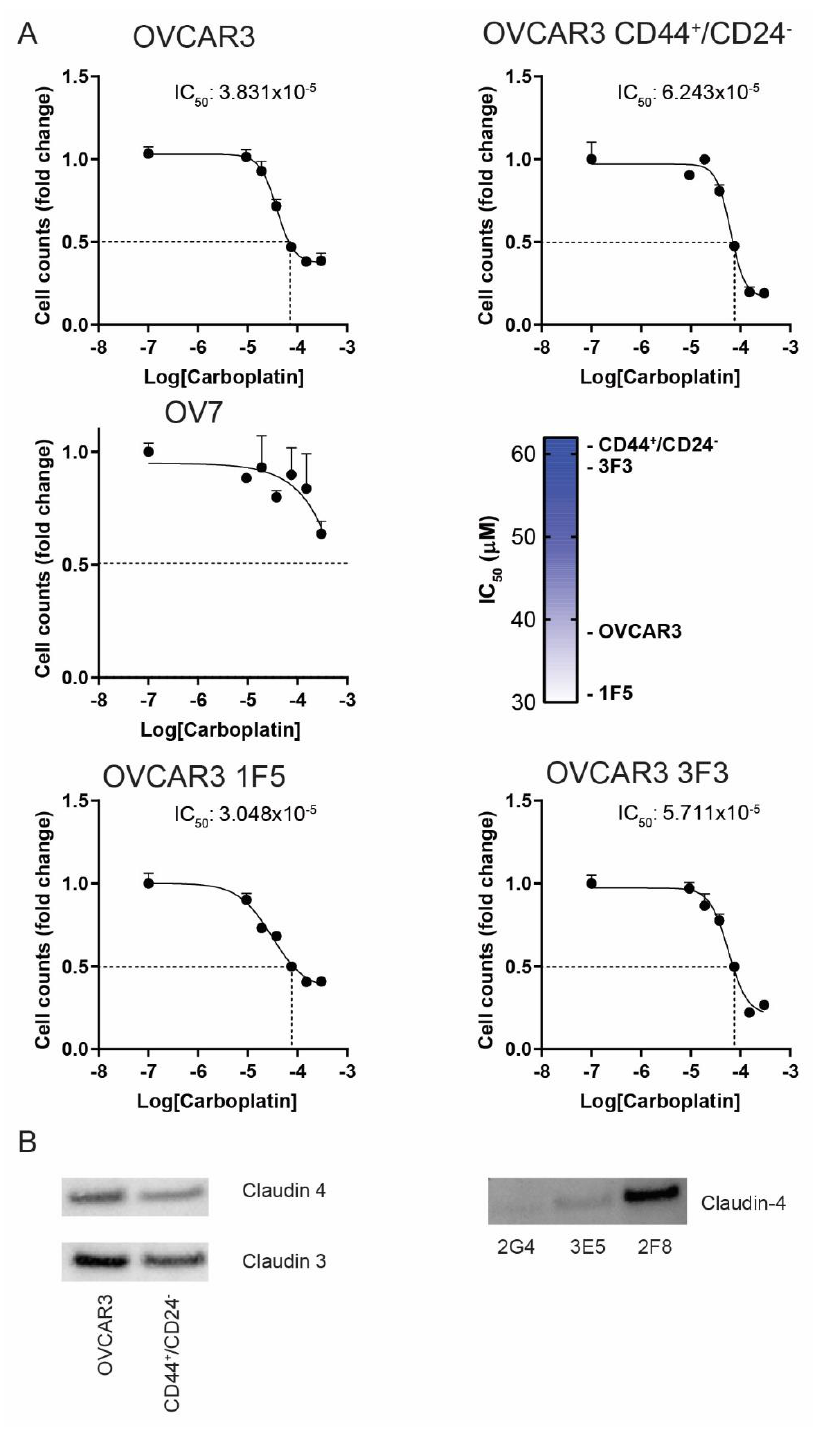
Figure 6. CL HGSOC cells exhibit increased resistance to carboplatin. ( A ) OV7, unsorted OVCAR3 and CD44 + /CD24 − sorted OVCAR3 cell lines as well as 1F5 and 3F3 cell clones were treated with increasing doses of carboplatin (0–300 µ M). After 48 h the cell number was evaluated and fold changes versus untreated cells were calculated. IC 50 values are displayed. Values represent the mean ± SEM of two independent experiments. ( B ) Western blot analysis of Claudin expression in OVCAR3, CD44 + /CD24 − sorted OVCAR3 and selected clones. Table 2. Claudin low tumor marker genes.